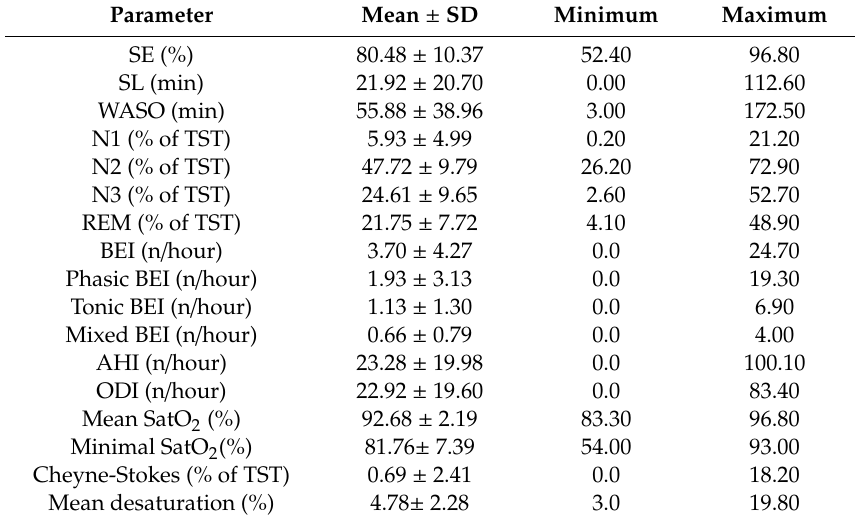
Table 1. Polysomnographic indices in the studied group ( n = 110). Parameter